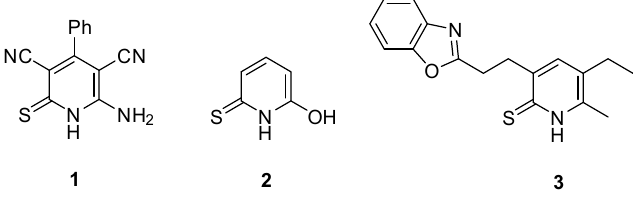
Figure 1. Biologically active thioamide-containing azaarenes.